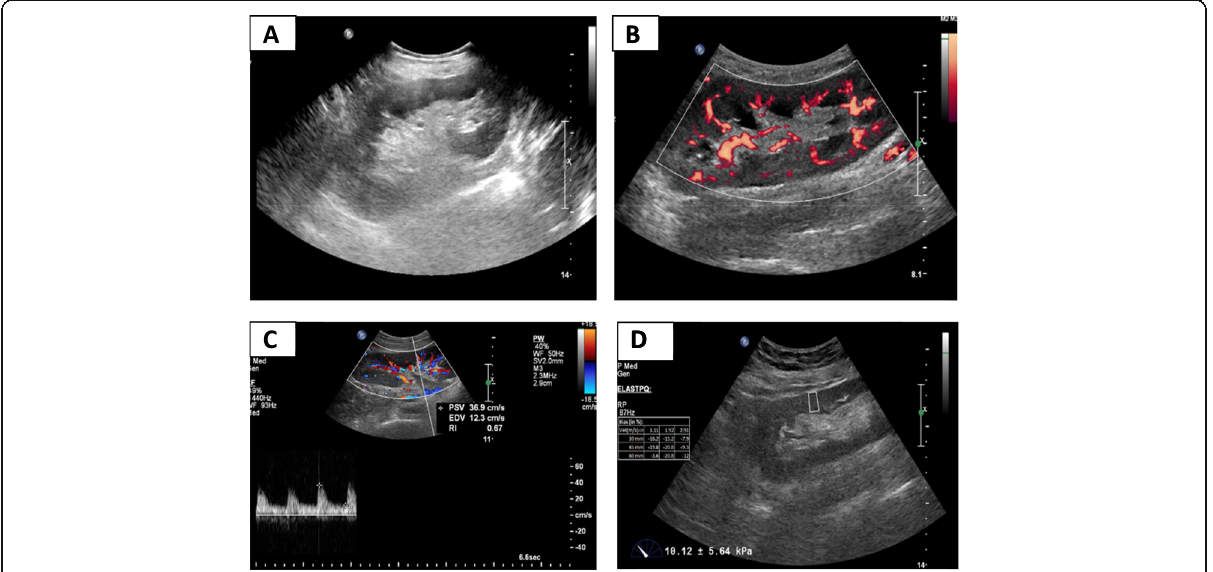
Fig. 1 A 27-year-old male patient who underwent renal transplantation in 2017, on 19 April 2018, was presented with a creatinine level of 2.2 mg/dl. a Graft US showed average size graft at the right iliac region with normal echo pattern, no back pressure, and no peri-graft